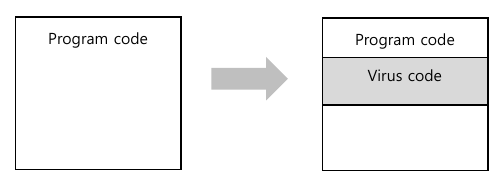
Fig. 3. The example of an infection by an inserting virus.